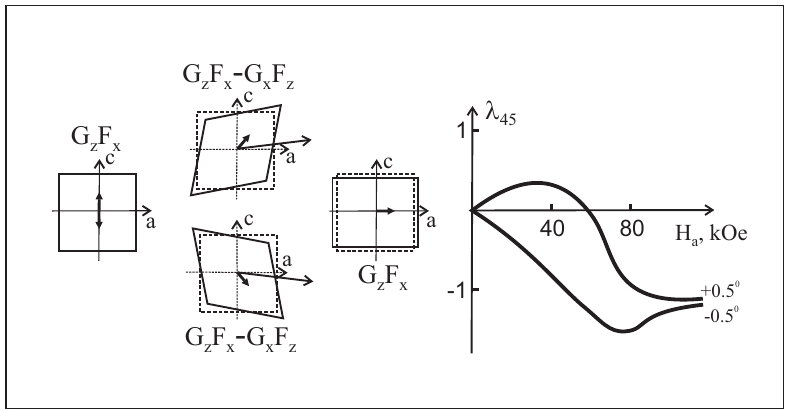
Figure 6. (Color online) The field dependence of magnetostriction in YFeO 3 for the external field with orientation near H (cid:107) a [53]. Left-hand side—an illustration of the nature of shear deformation in antiferromagnetic domains with different orientations of the magnetic